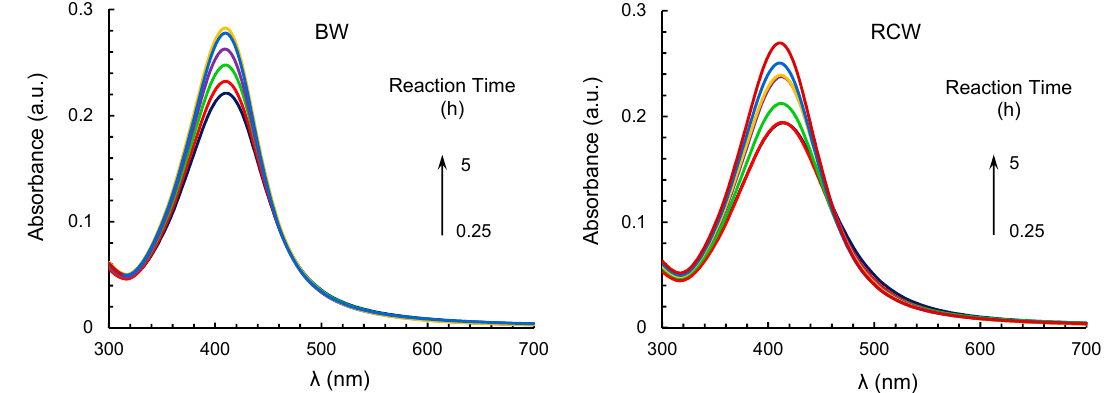
Figure 2. Spectrophotometric monitoring of the formation of silver nanoparticles (Ag-NPs) in reaction media containing silver nitrate and bilberry waste (BW) or red currant waste (RCW).